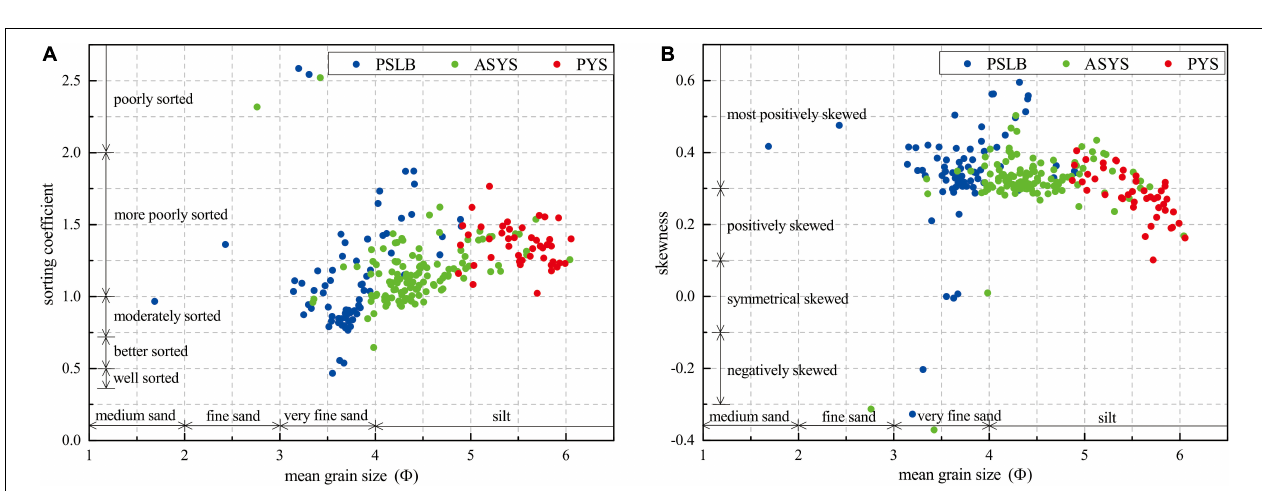
FIGURE 6 | The bivariate plot of sorting coefficient versus mean grain size (A) and skewness versus mean grain size (B) of the tidal flat surficial sediments of the southern abandoned sub-delta and adjacent zones.